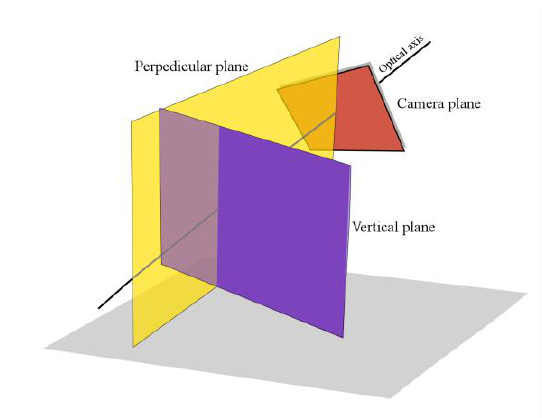
Figure 5: Definition of the projection plane (coloured purple) 2.2.3 Orthophoto generation: The size of the orthophoto is defined by the border points of the point cloud. However, in the case the point cloud covers a larger part of the object than the image, it would result in a large sized orthophoto with many empty pixels and very little useful information. Although the quality of the orthophoto is not affected, to avoid excessive processing time, a method of approximately limiting the point cloud to the image extents is applied. The ground sampling distance is determined based on the desired scale of the final output and subsequently the orthoimage surface is divided into empty grid cells. centre of each grid cell are obtained from the DSM.